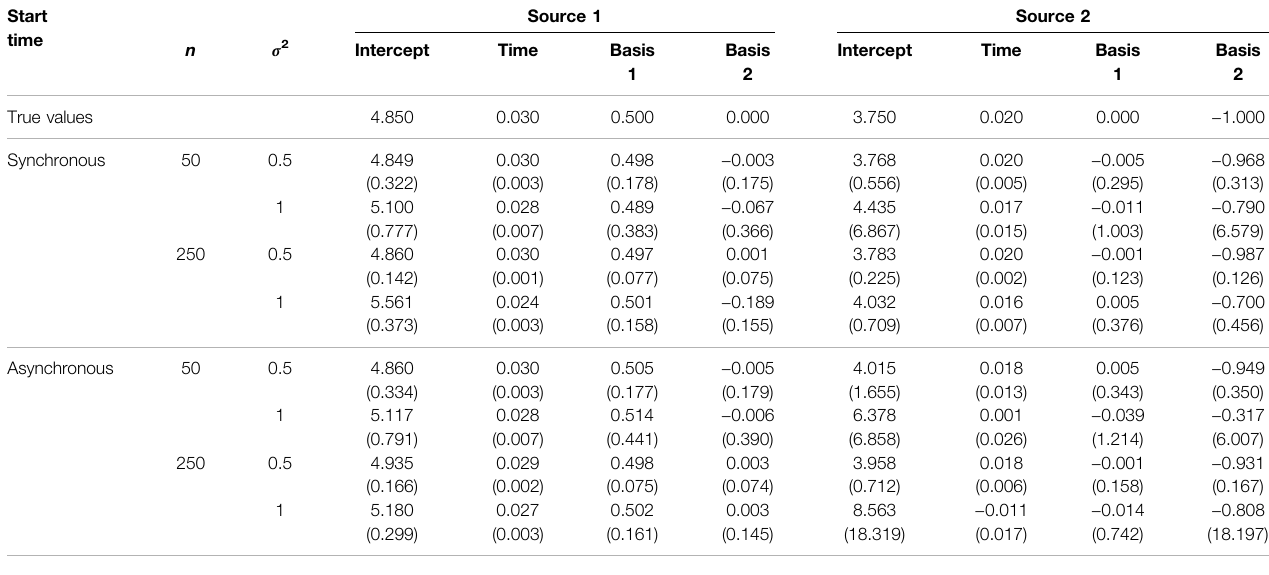
TABLE 2 | The mean parameter estimates and standard deviation for two-source models fi t to simulated data. Two sets of estimates are reported corresponding to a (0,0) placement for a fi rst source and a (2000,2000) placement for a second source, with temporally synchronous or asynchronous epidemics ( n is the sample size.)